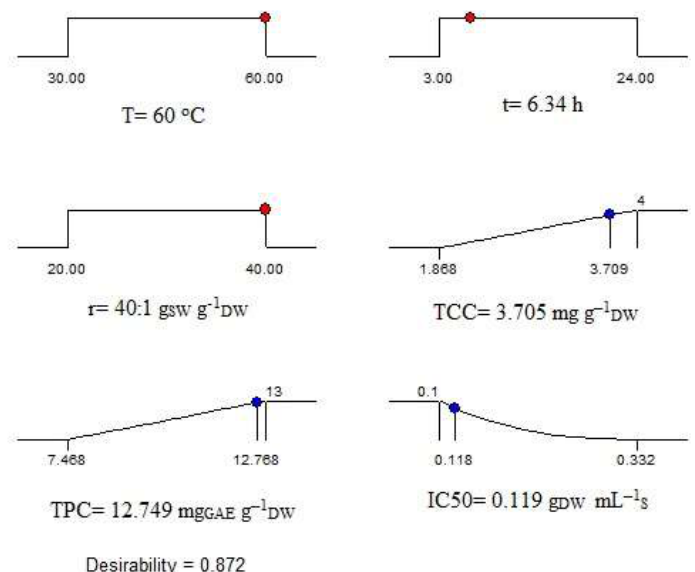
Figure 4. Optimization of the C. vulgaris biomass extraction using the solvent